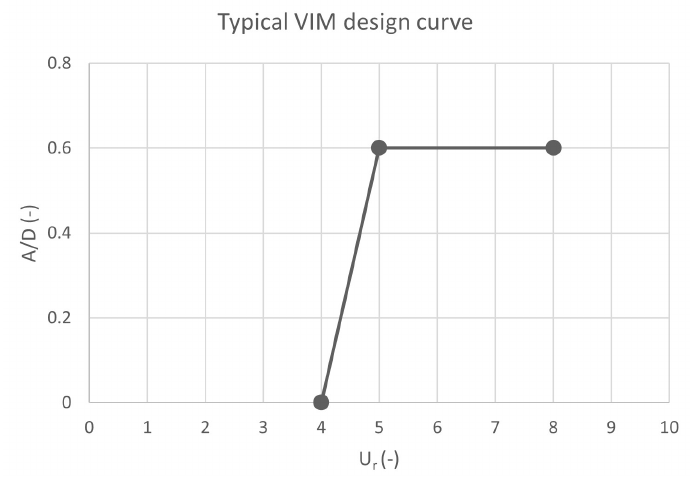
Figure 9. A typical VIM design curve: normalized VIM design amplitude versus reduced velocity, reproduced Figure 10 of